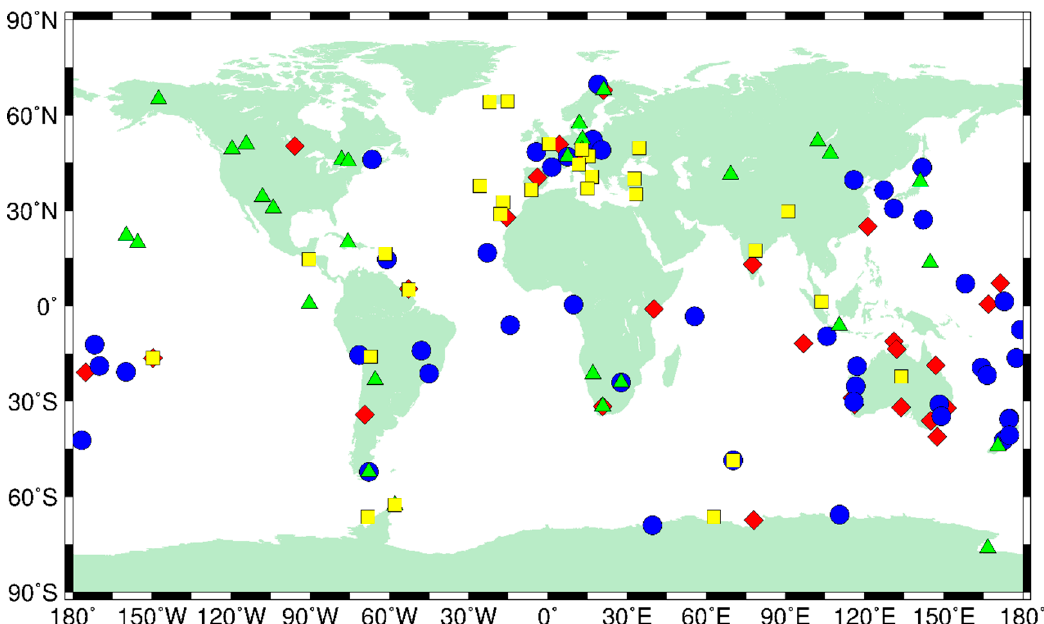
Figure 3. The distribution of GLONASS stations selected for integer ambiguity fixing. The red diamonds denote the SEPT POLARX5 receivers, the blue dots denote the TRIMBLE NETR9 receivers, the yellow squares denote the JAVAD TRE_G3TH DELTA receivers and the green triangles denote the LEICA GR25 receivers. The firmware versions for different types of receivers are ignored in this study.